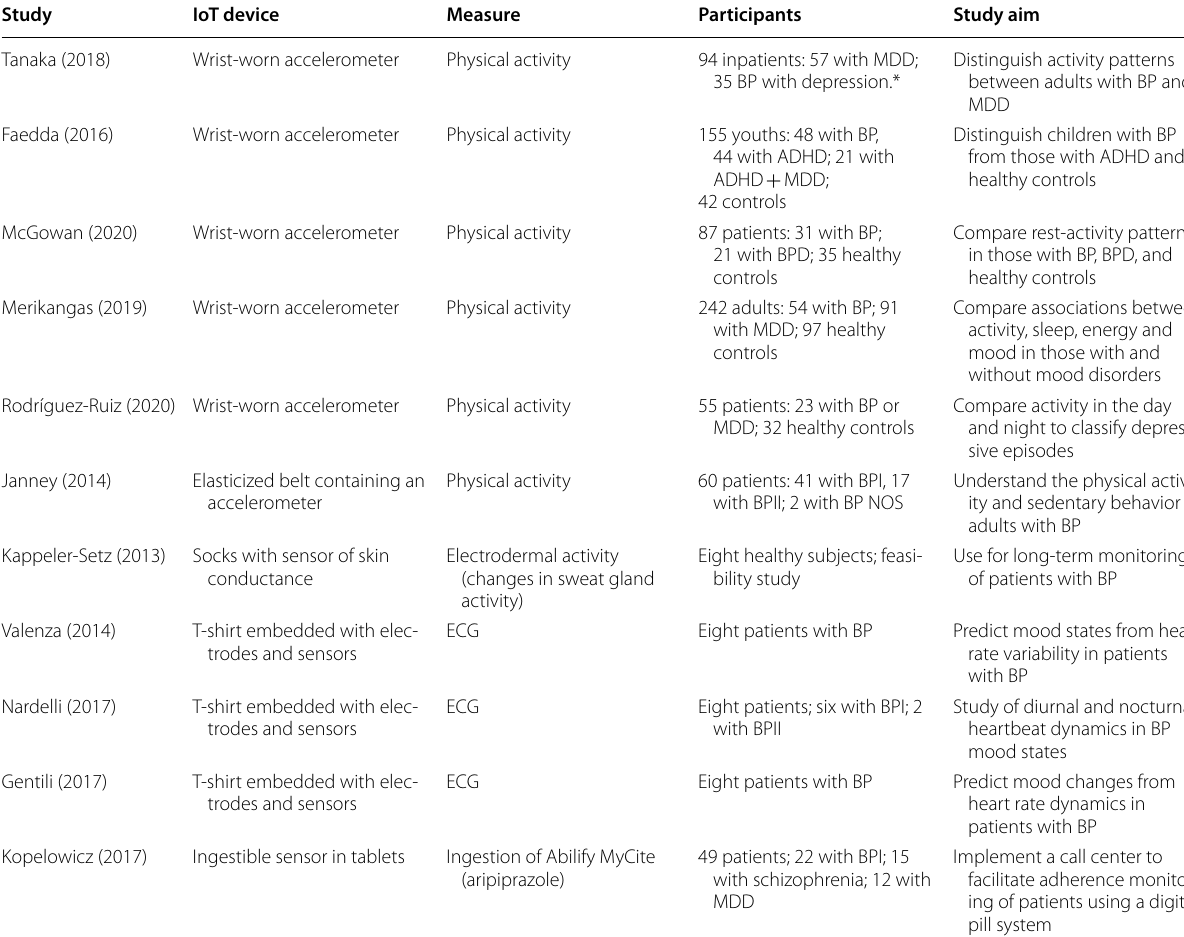
Table 2 Example studies of patients with bipolar disorder using data from IoT devices (wearable devices and ingestible